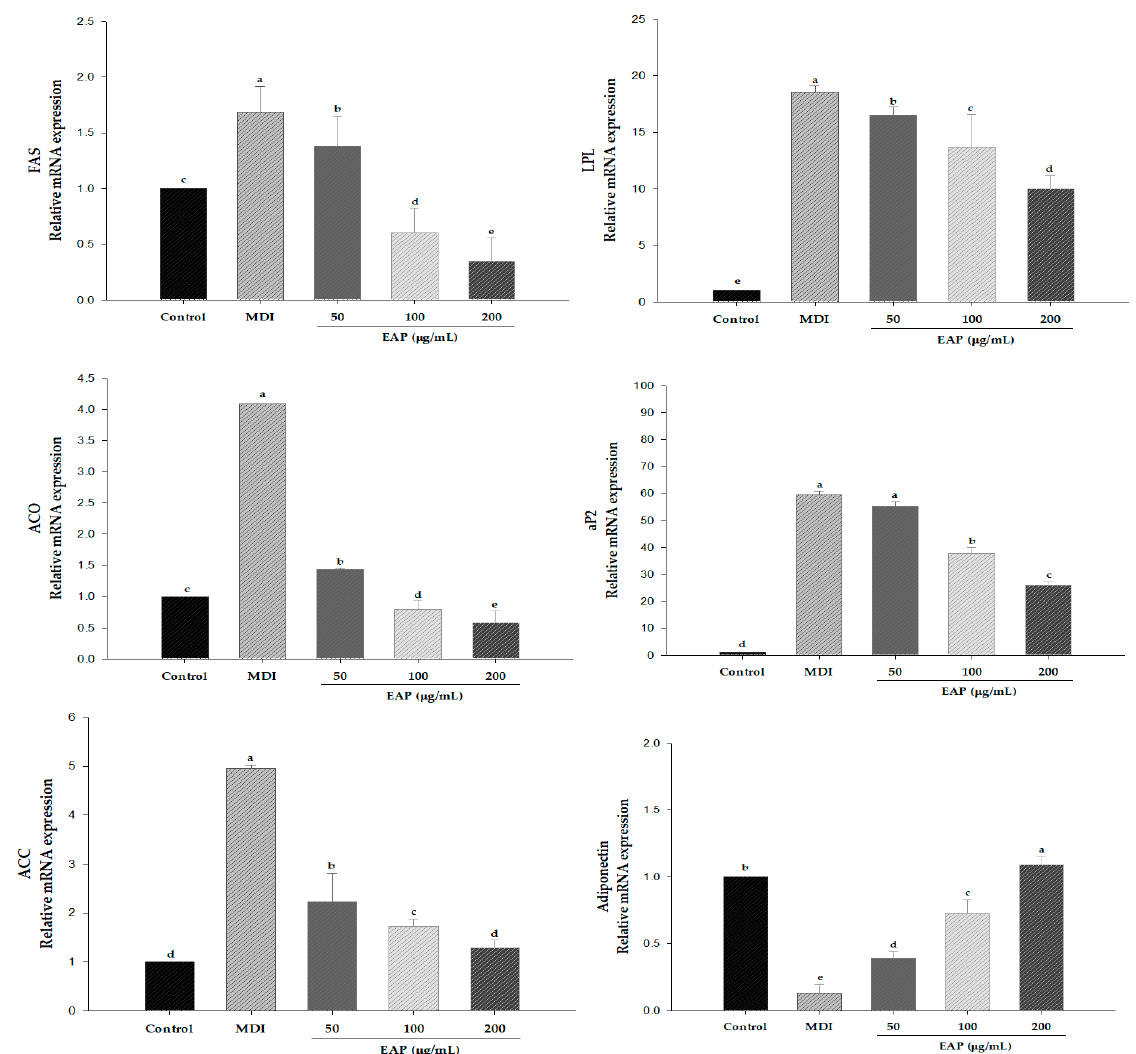
Figure 6. Effects of EAP on mRNA expressions of FAS, LPL, aP2, ACO, ACC and adiponectin genes in 3T3-L1 adipocytes. EAP: Erigeron annuus (L.) Pers. water extract. Cells were treated with EAP (50, 100, and 200 μ g/mL) for seven days during differentiation. At day seven, mRNA expression levels of FAS, LPL, aP2 and adiponectin were determined by real-time PCR. Results are expressed as fold increase compared to the control after normalizing against GAPDH expression level. Values are presented as mean ± standard deviation. Differences between means were considered statistically significant at P < 0.05.